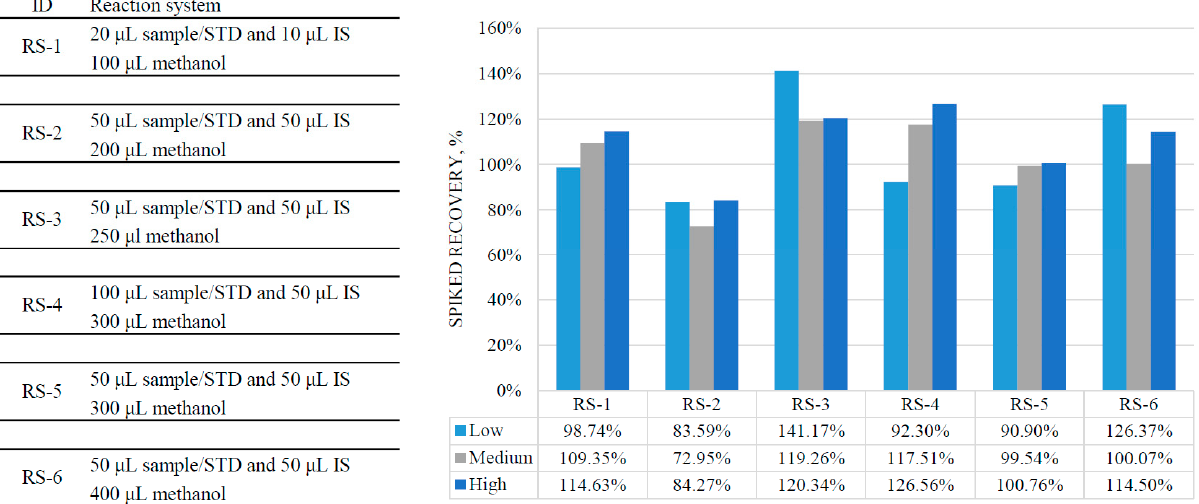
Figure 1. Optimization results of reaction systems in sample preparation.